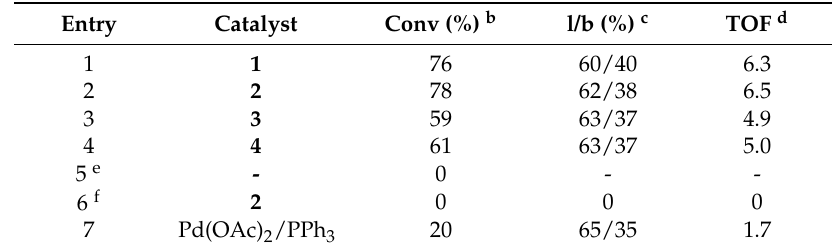
Table 1. The effect of catalyst structure and phosphines in the methoxycarbonylation of 1-hexene using complexes 1 – 4 a